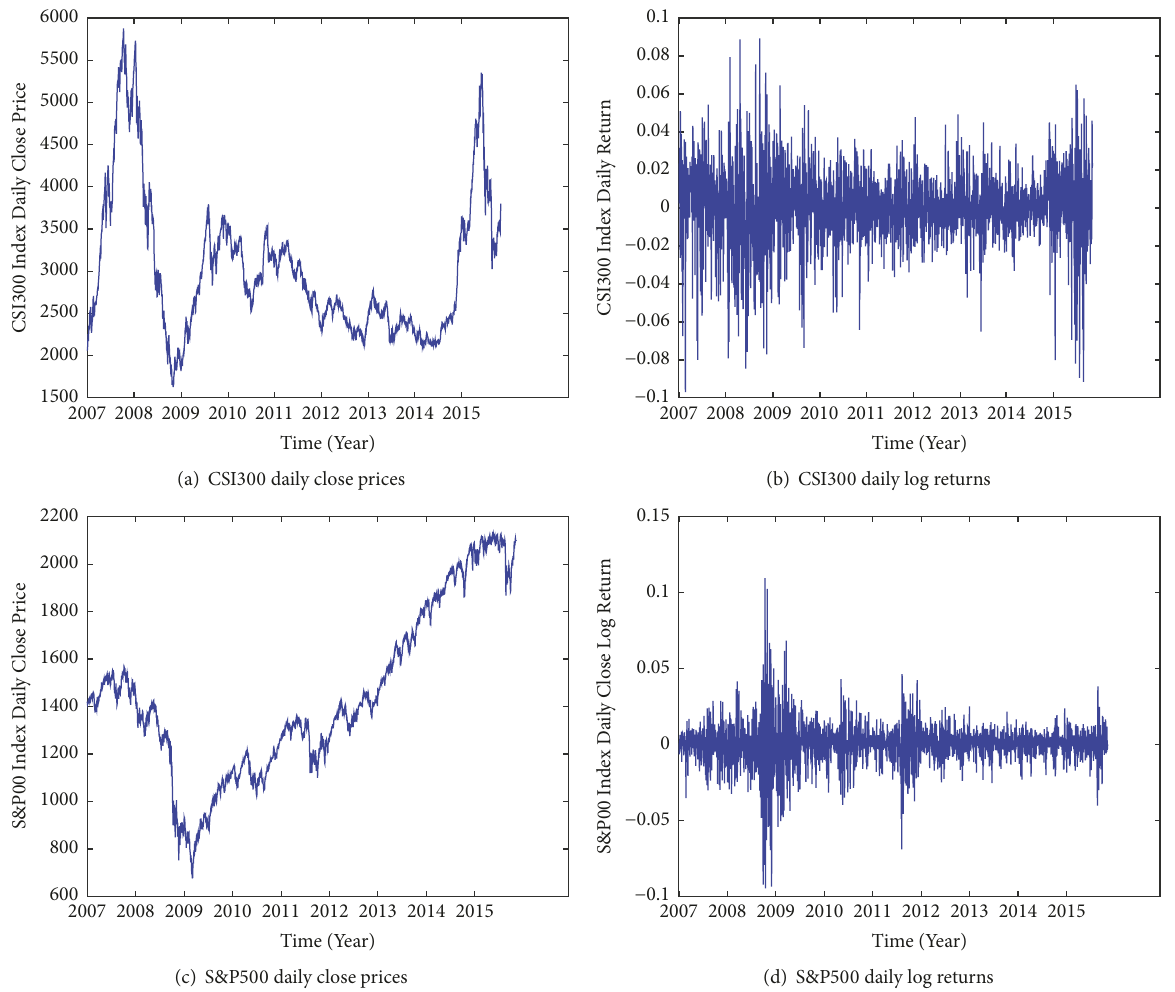
Figure 1: CSI300 index daily close prices (a) and log returns (b) in the study period between 04/01/2007 and 06/11/2015 with 2149 trading days. S&P500 index daily close prices (c) and log returns (d) in the study period between 04/01/2007 and 06/11/2015 with 2228 trading